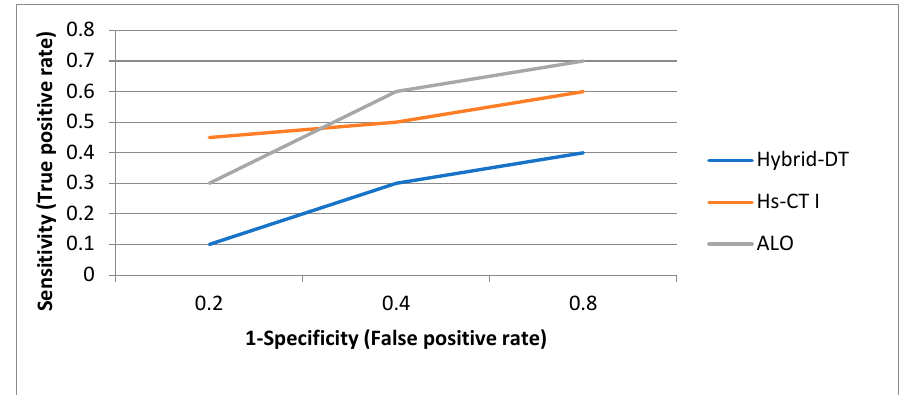
Figure 14. Comparison of Sensitivity-Specificity.